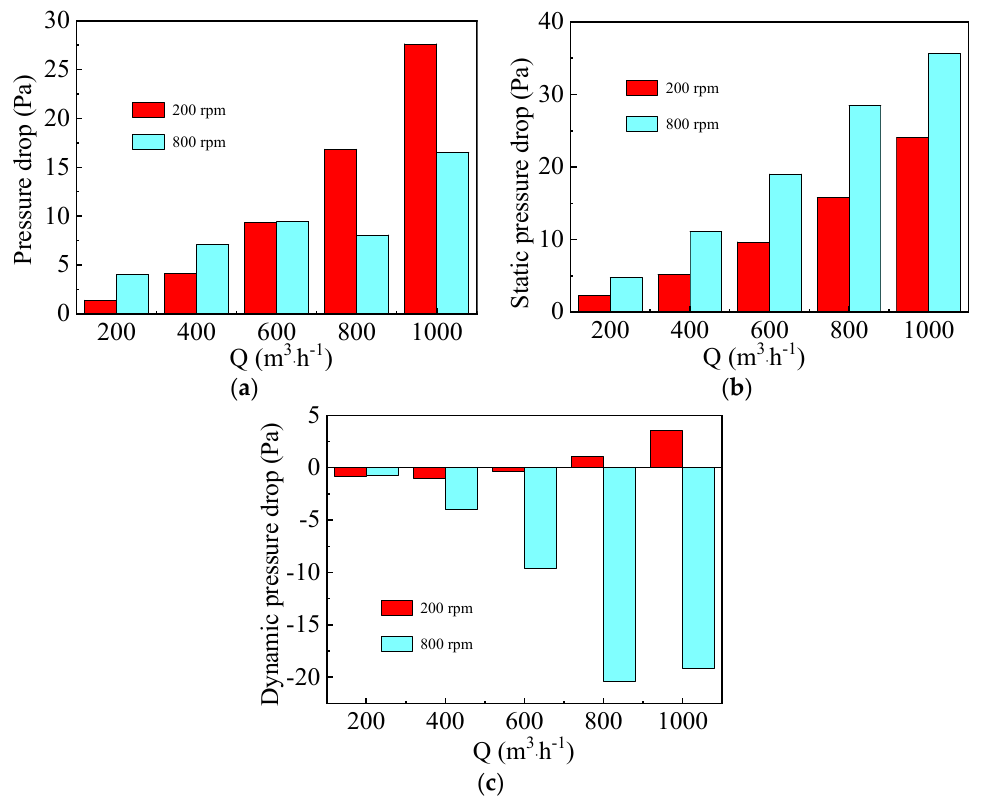
Figure 10. The effect of the gas flow rate on the pressure drop in the packing zone. ( a ) Pressure drop; ( b ) static pressure drop; ( c ) dynamic pressure drop.